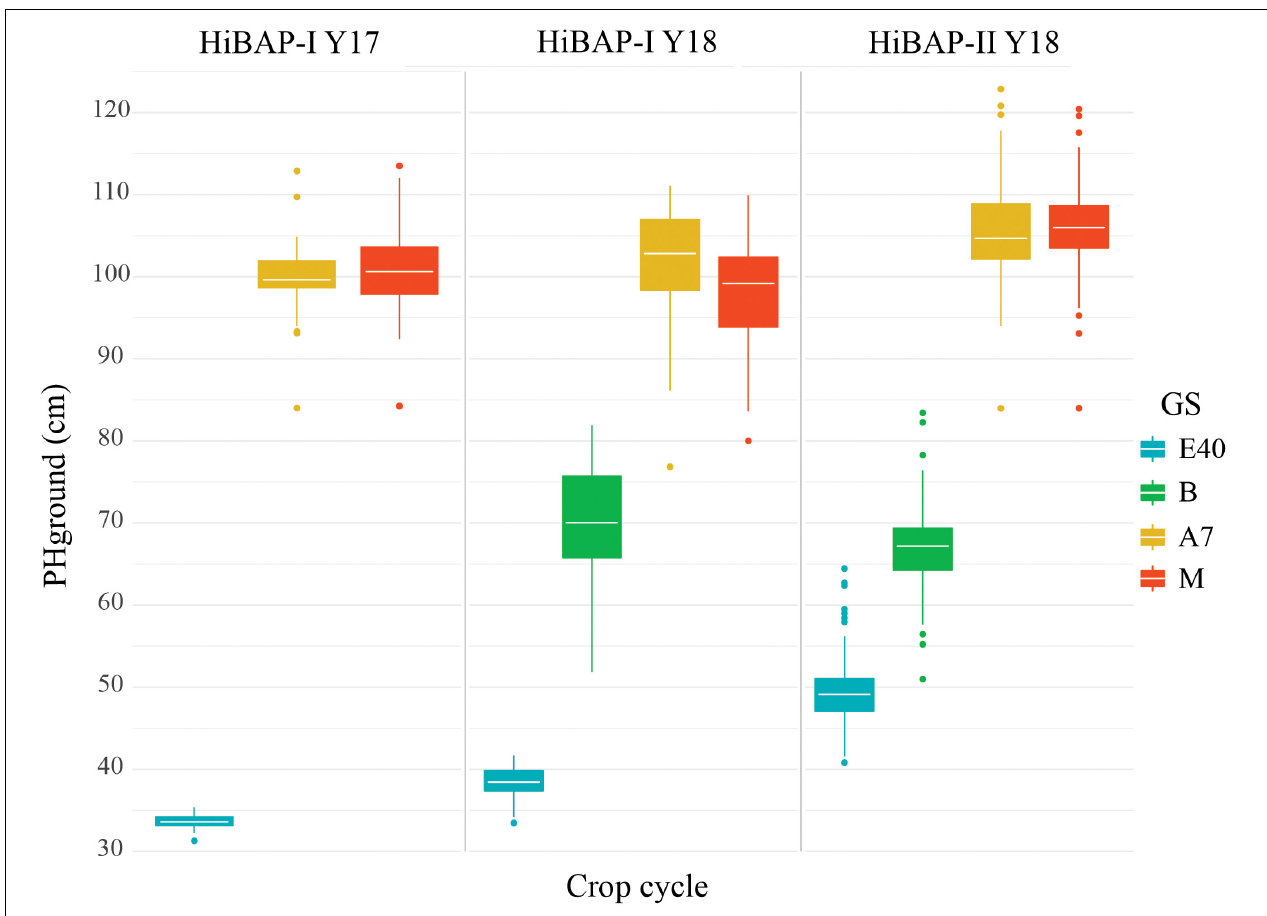
FIGURE 4 | Boxplot of BLUEs for wheat plant height (PH, cm) in each of the observed crop cycles at the following growth stages (GS): 40 days after emergence (E+40), booting (B), 7 days after flowering (A+7) and at physiological maturity